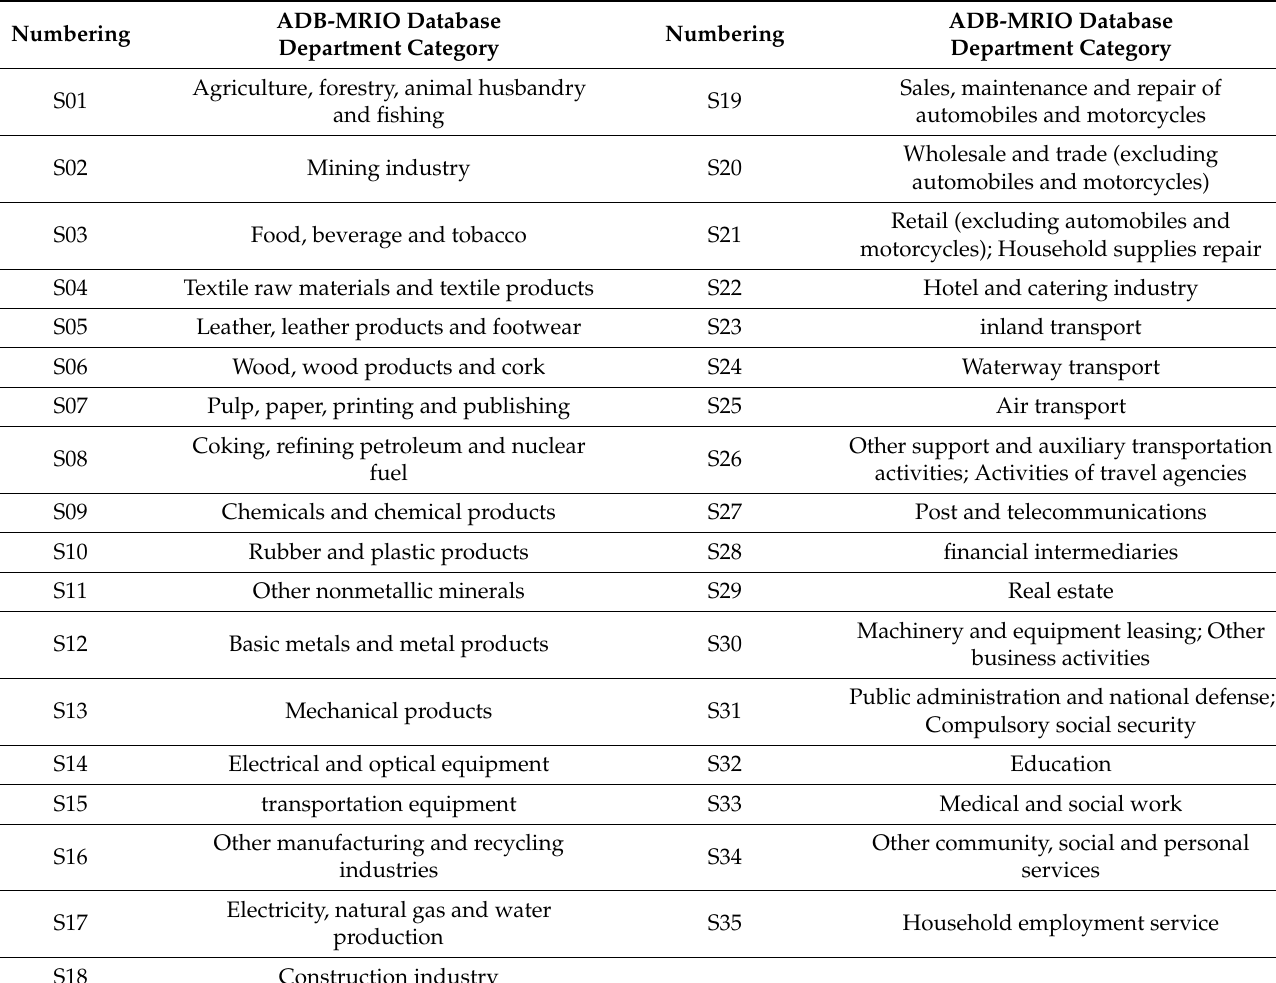
Table A2. Department category and Numbering in ADB-MRIO.